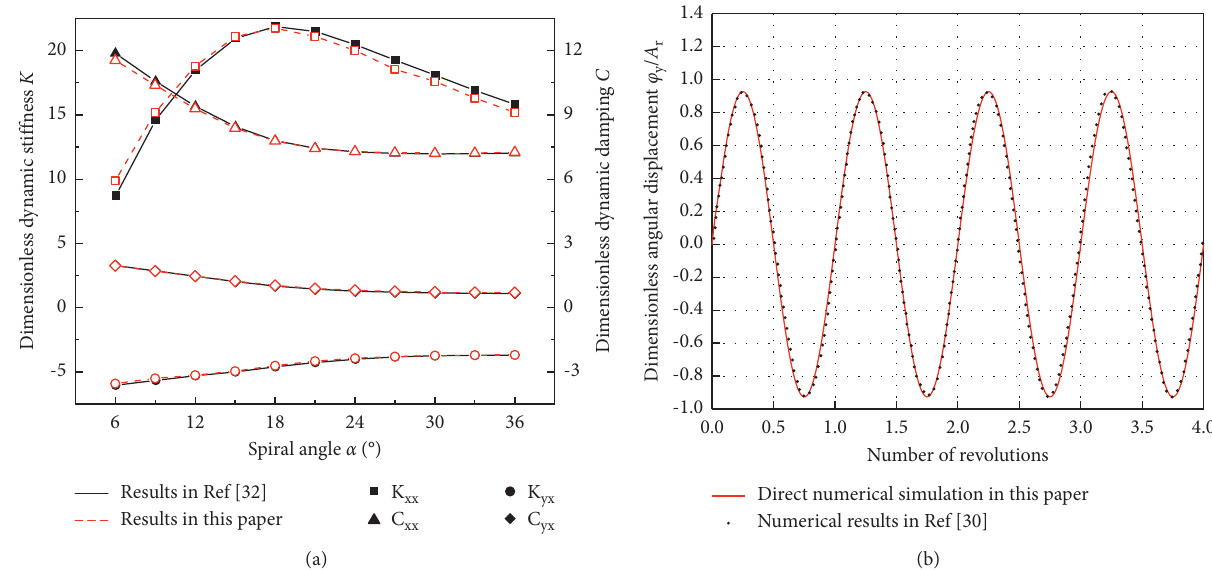
Figure 7: Verification of angular dynamic characteristics of DGS: (a) film dynamic coefficients and (b) angular response displacement of the floating